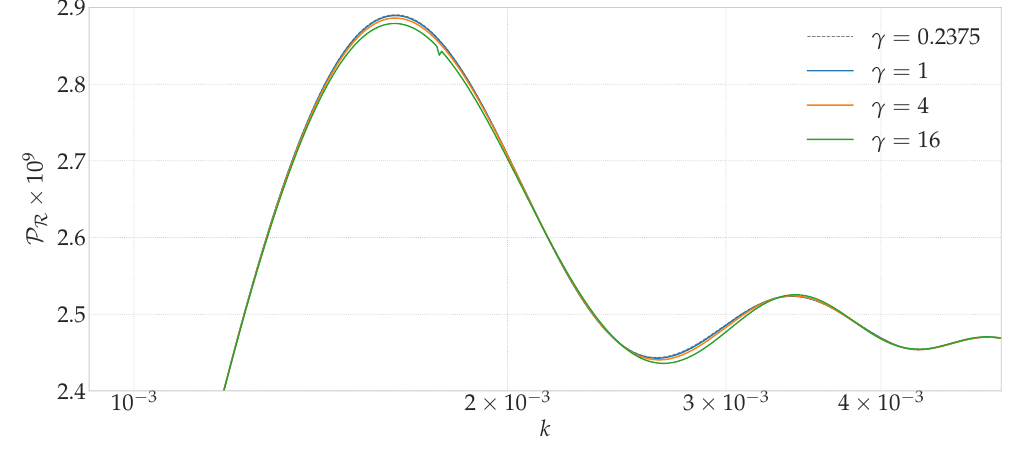
Figure 13. Primordial power spectrum of the NO-vacuum in hybrid LQC for values of the Immirzi parameter between 0.2375 and 16. The background solution was studied in Section